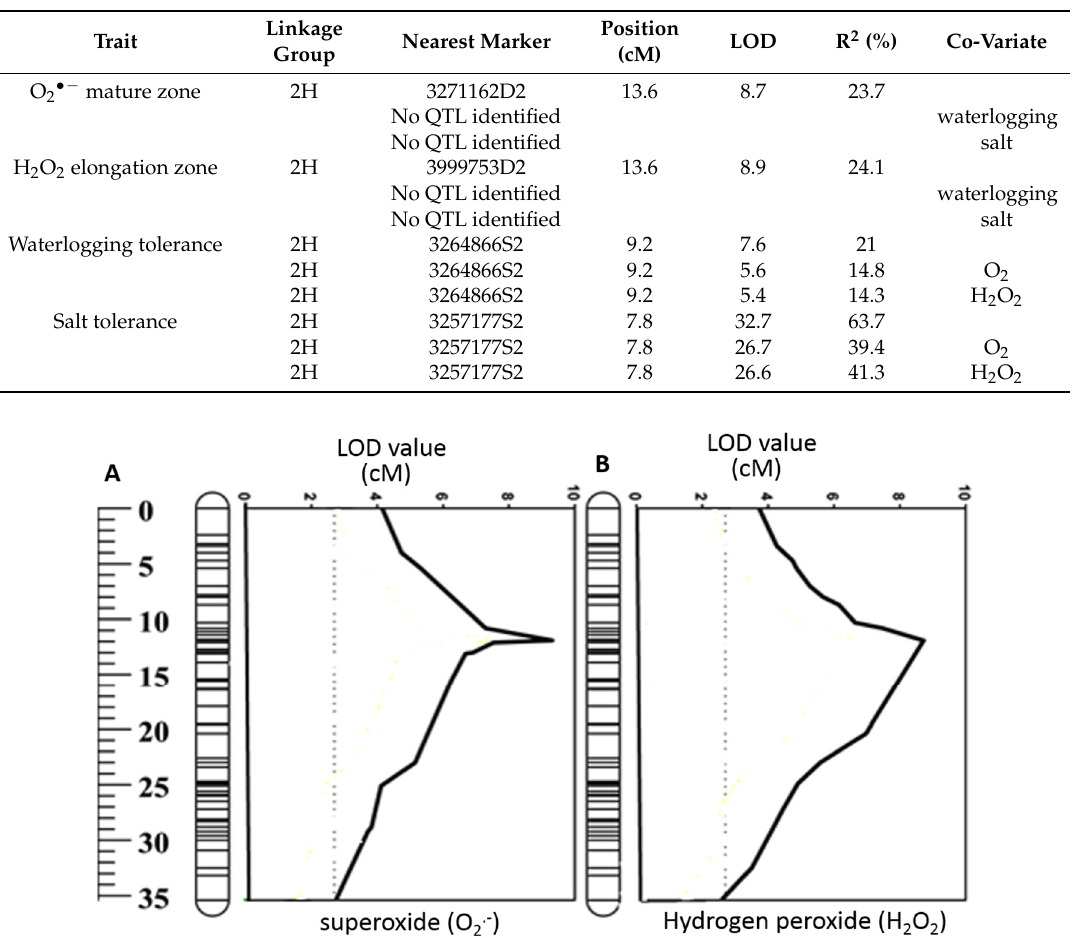
Table 2. QTL on 2HS for superoxide radical (O 2 •− ), hydrogen peroxide (H 2 O 2 ), salt, and waterlogging